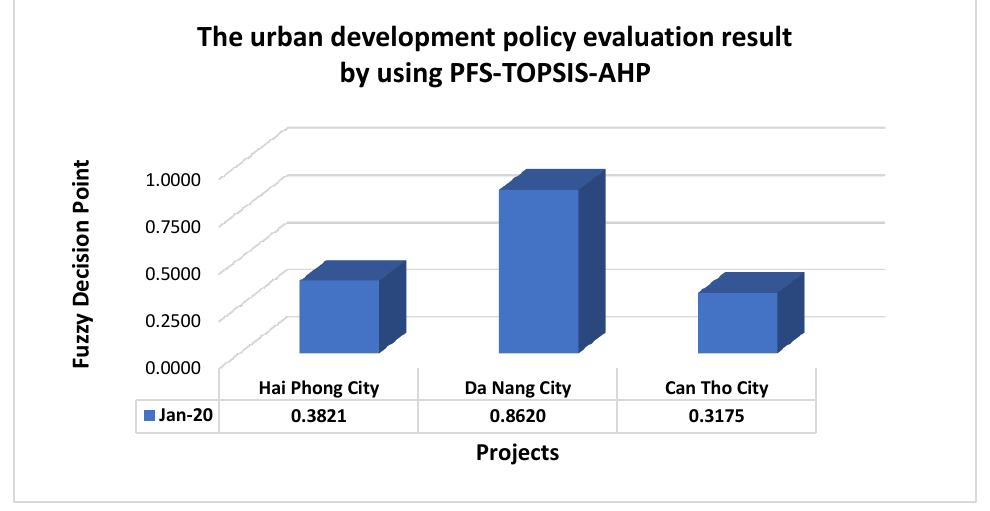
Figure 4. The urban development policy evaluation result by using PFS-TOPSIS-AHP